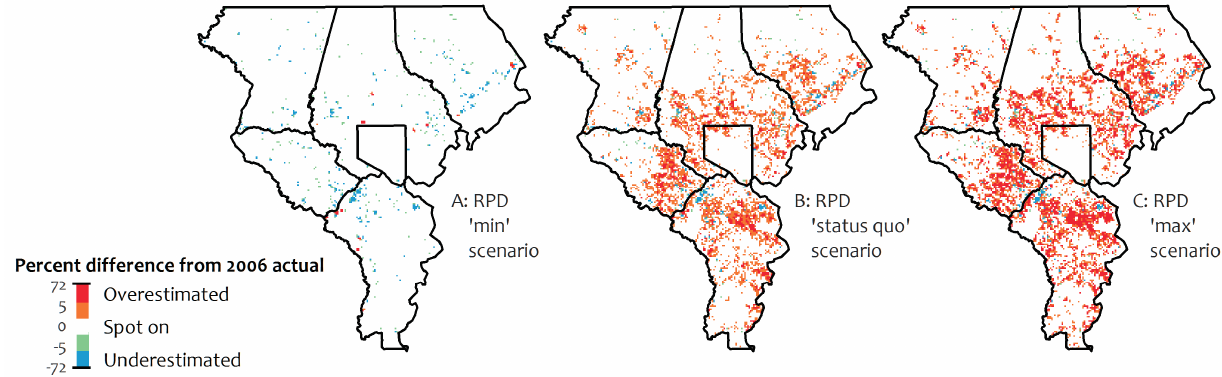
Figure 7. Maps showing constrained validation results for ( A ) the MIN, ( B ) Status Quo and ( C ) MAX scenarios run with the RPD exclusion/attraction